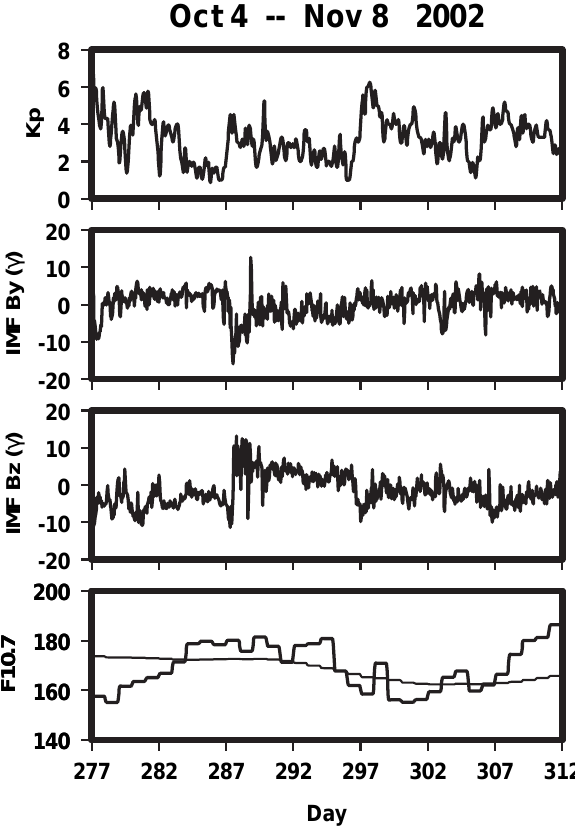
Fig. 3. Solar, IMF, and geomagnetic conditions during the month- long study period. The bottom panel shows the F 10 . 7 solar radio flux index and its 81-day running average. The middle two panels show the IMF B y (nT) and B z (nT), while the top panel shows the geomagnetic K p